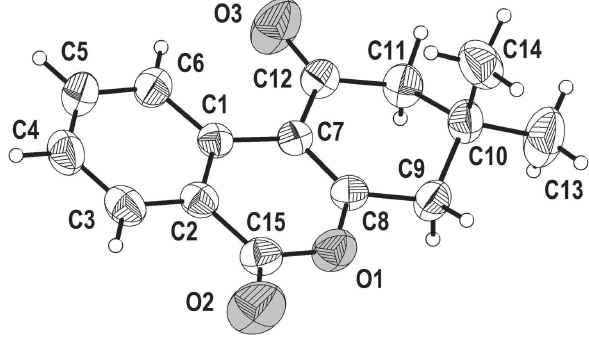
Table 1: Data collection and